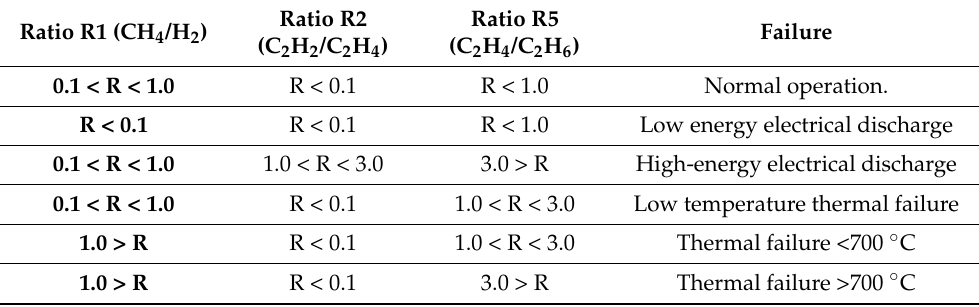
Table 8. Rogers Method—Relationship between ratios and failures (adapted from [54]).